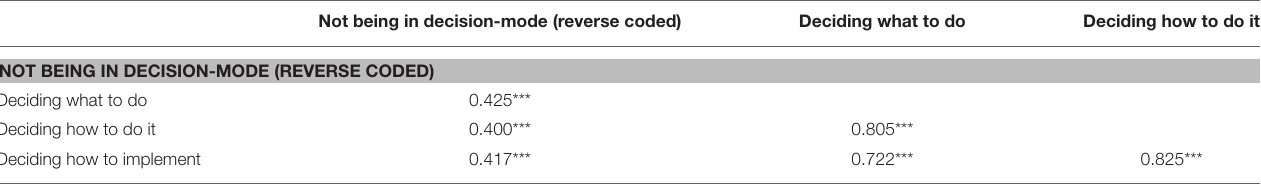
TABLE 2 | Correlations between agreements to the statements indicating the different stages of decision-making ( N = 3.787). Not being in decision-mode (reverse